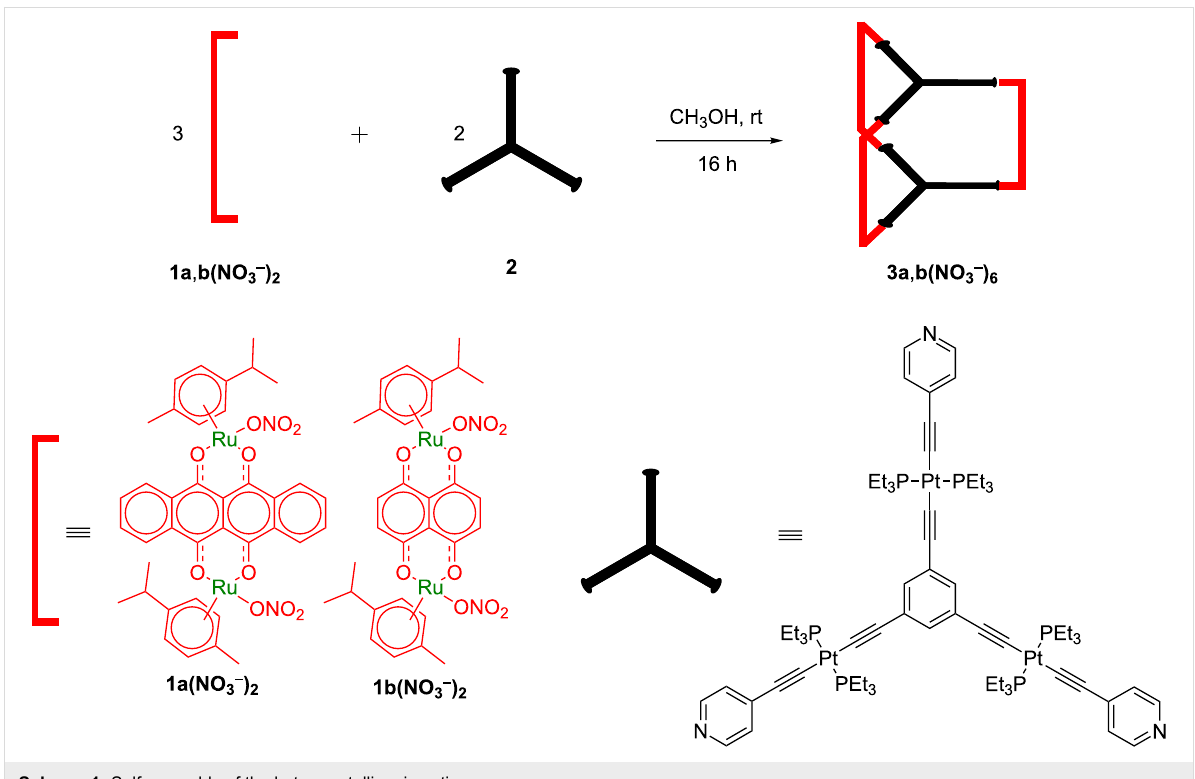
Scheme 1: Self-assembly of the heterometallic prismatic